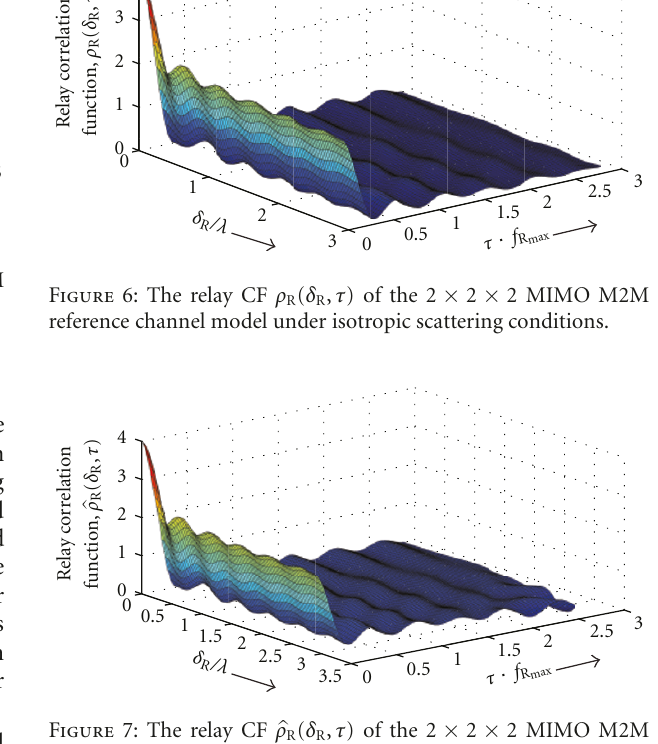
Figure 7: The relay CF (cid:22) ρ R ( δ R , τ ) of the 2 × 2 × 2 MIMO M2M stochastic channel simulator under isotropic scattering